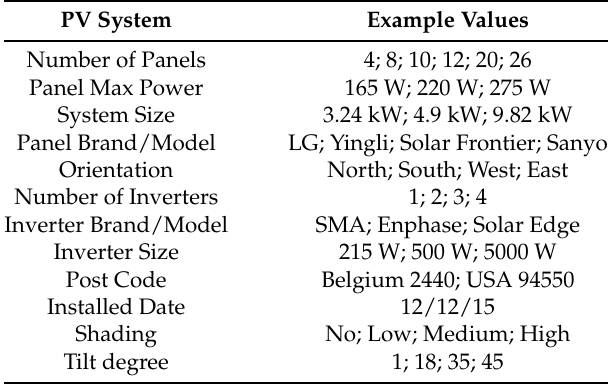
Table 1. Specifications of PV systems at pvoutput.org